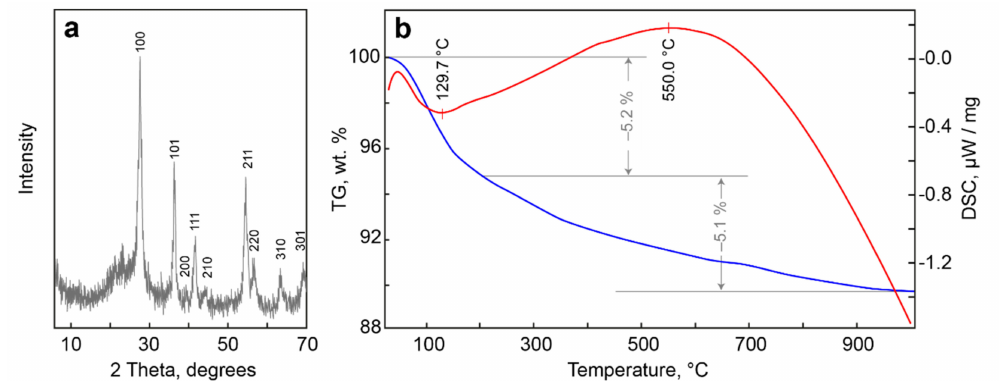
Figure 5. Powder X-Ray di ff raction profile ( a ) and TG / DSC curves of TSP ( b ). Indexed peaks correspond to rutile.